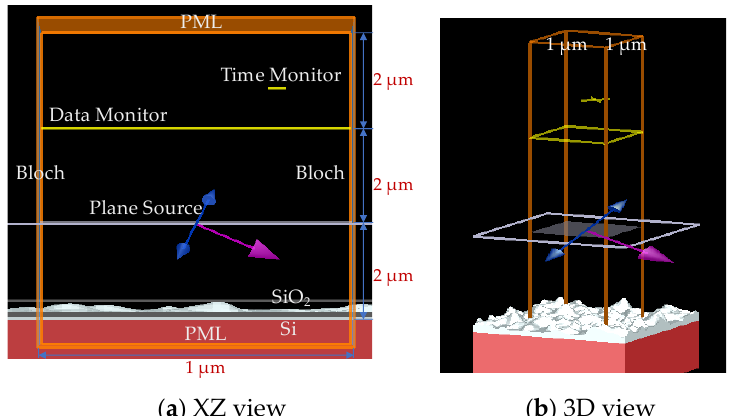
Figure 3. The location diagram of each component in the ( a ) XZ view and ( b ) 3D view of the FDTD Solutions simulation interface.